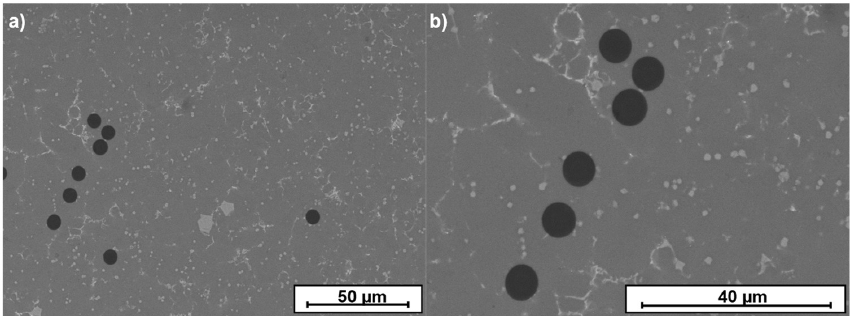
Figure 4. SEM images of the unidirectional carbon fibers in the Al matrix: ( a ) microstructure of aluminum reinforced with unidirectional carbon fiber; and ( b ) magnification of ( a ). The microstructures of the samples obtained by optical microscopy are shown in